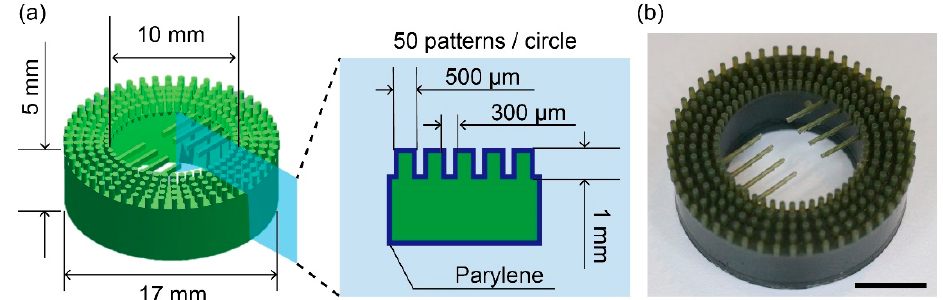
Figure 2. Design of the anchoring device with pillars: ( a ) Schematic illustration of the anchoring device with dimensions; ( b ) Image of the fabricated anchoring device. Scale bar is 5 mm.